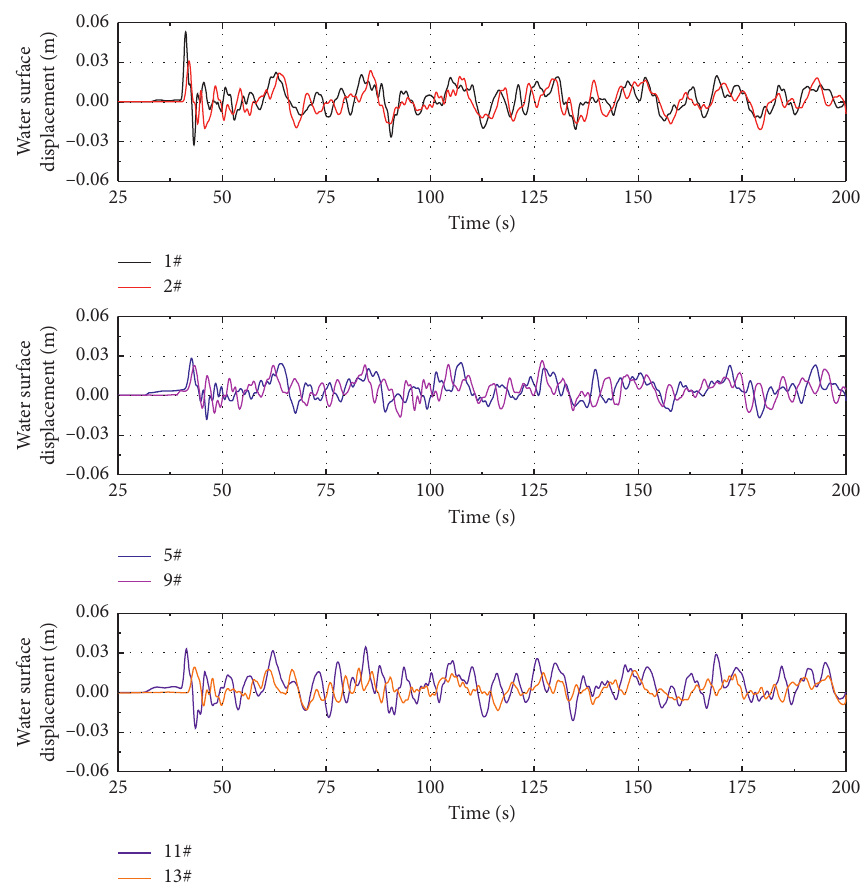
Figure 9: The water surface displacement from Scenario 47 with l � 1.0m, w � 0.5 m, s � 0.4m, h � 0.88m, and α � 60 ° .